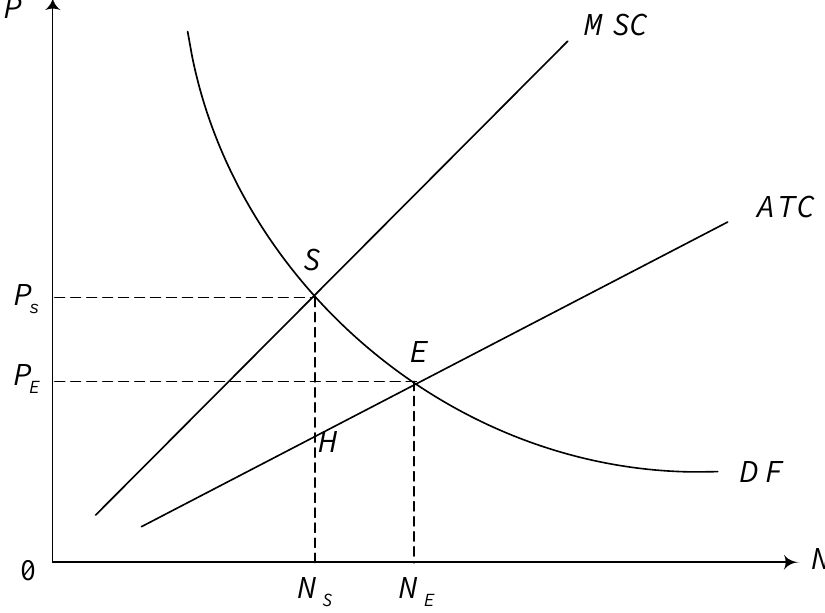
Figure 5. Demand and supply of daily